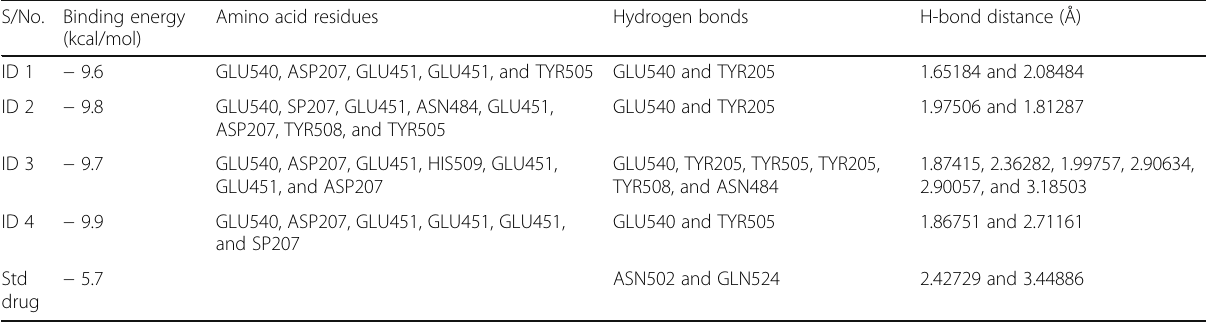
Table 7 The binding energy, amino acid residues, hydrogen bonds, and hydrogen bond distance of design compounds and the standard drug S/No. Binding energy (kcal/mol)